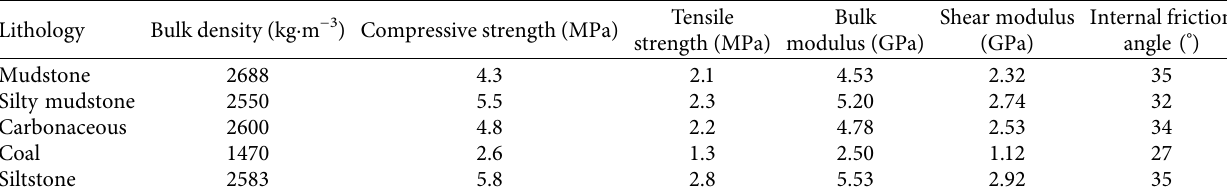
Figure 5: Numerical calculation model: (a); (b) schematic diagram of computational model; (c) the original bolt/cable unit; (d) the constant resistance coupling support bolt/cable unit; and (e) dual-control constant-resistance coupling control. Table 2: Rock mechanics